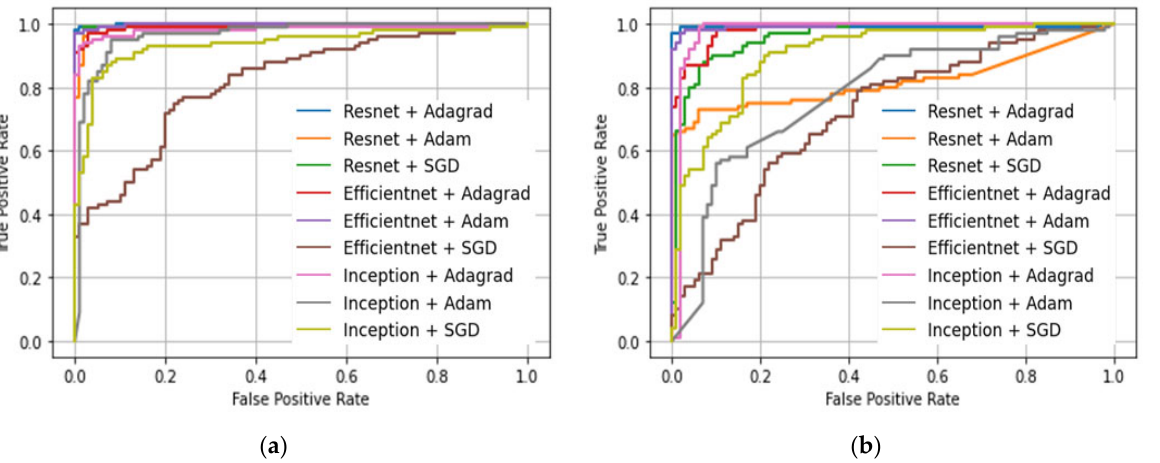
Figure 4. ROC curves comparison. ( a ) Multistage transfer learning. ( b ) Conventional transfer learning. SGD: Stochastic gradient descent.